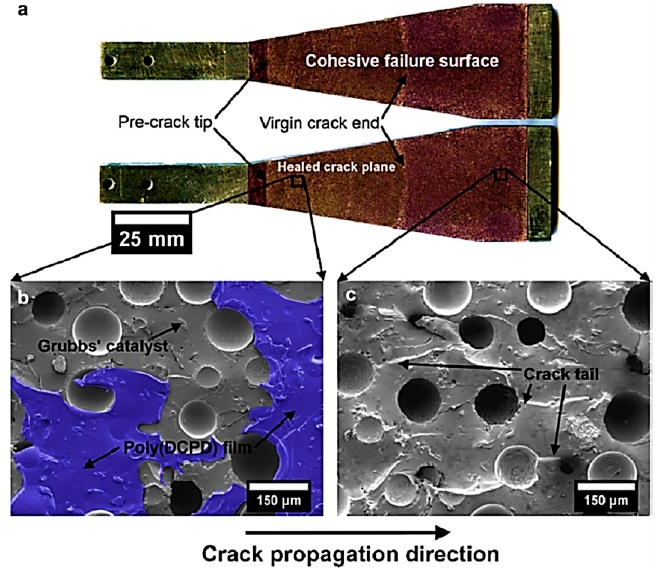
Figure 2. Quasi-static fracture plane after healing of self-healing specimen: ( a ) optical images of mating fracture surfaces showing cohesive fracture; ( b ) SEM image of healed fracture surface showing polymer film (blue) formed during self-healing; and ( c ) SEM image of fracture surface at end of sample created during imaging (unhealed) revealing crack tails indicative of toughening mechanism SEM = scanning electron microscopy. Reprinted with permission from [49]. 2011, Elsevier.